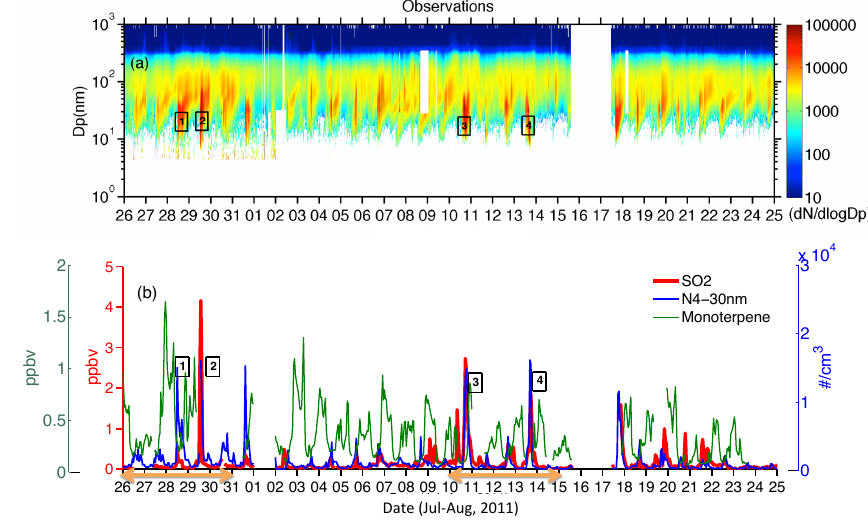
Figure 2. (a) Time series of number size distribution of submicron particles during BEACHON-RoMBAS. (b) Temporal variations in number concentrations of 4–30nm diameter particles ( N 4 − 30nm ) (blue), SO 2 (red), and monoterpene (green) mixing ratios during the campaign. The four PBEs are selected (28 and 29 July and 10 and 13 August) for comparisons with the model. The orange lines indicate the periods simulated with WRF-Chem.